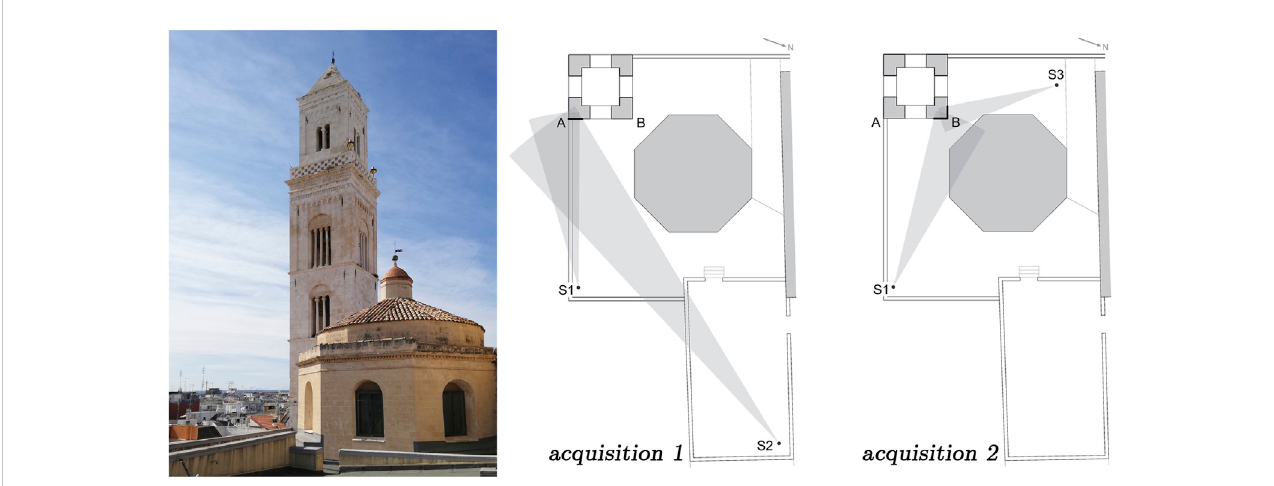
FIGURE 1 Different acquisitions that should be carried out with multiple interferometric radar systems to reconstruct full three-dimensional mode shapes of masonry constructions (S1, S2, and S3 represent the radar positions; the gray triangles represent the cone of view of the interferometric radar systems) (Castellano et al.,